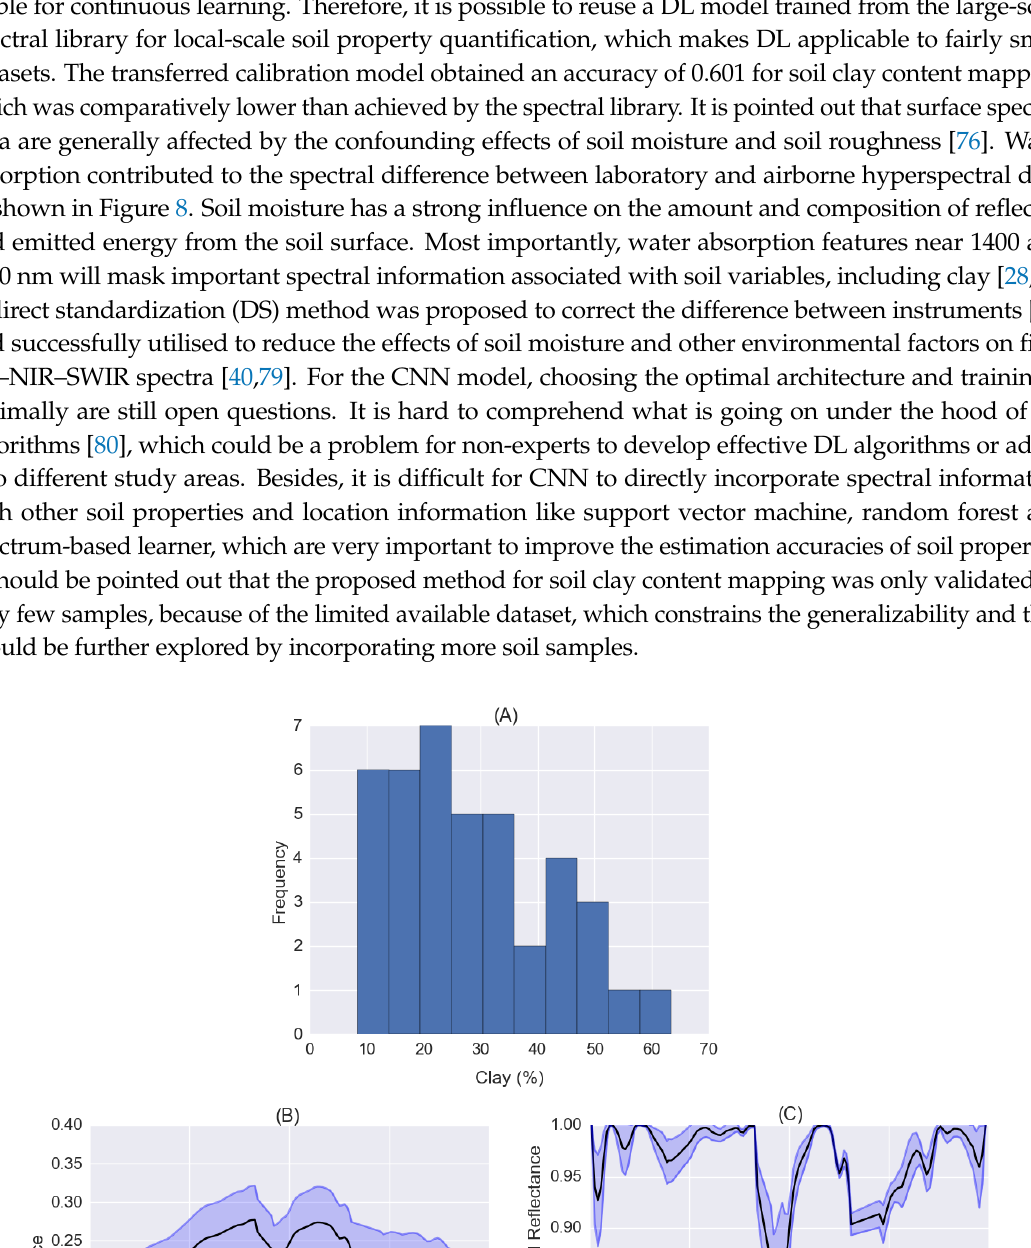
Figure 8. ( A ) Histogram of soil clay content distribution of soil samples collected from study area Cabo de Gata-Nijar; ( B ) mean soil reflectance spectrum and standard deviation derived from the hyperspectral image; ( C ) mean soil continuum-removal spectrum and standard deviation.